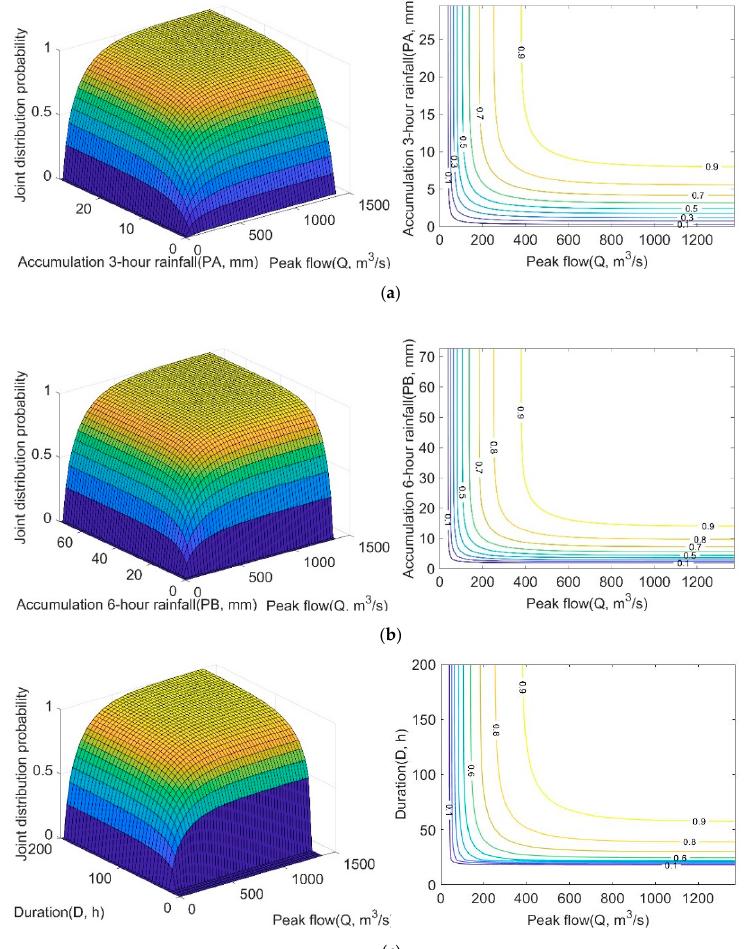
Figure 8. Bivariate joint probability distributions and probability isolines ( a ) PA–Q; ( b ) PB–Q; and ( c ) D–Q. Table 7. Statistical parameters.